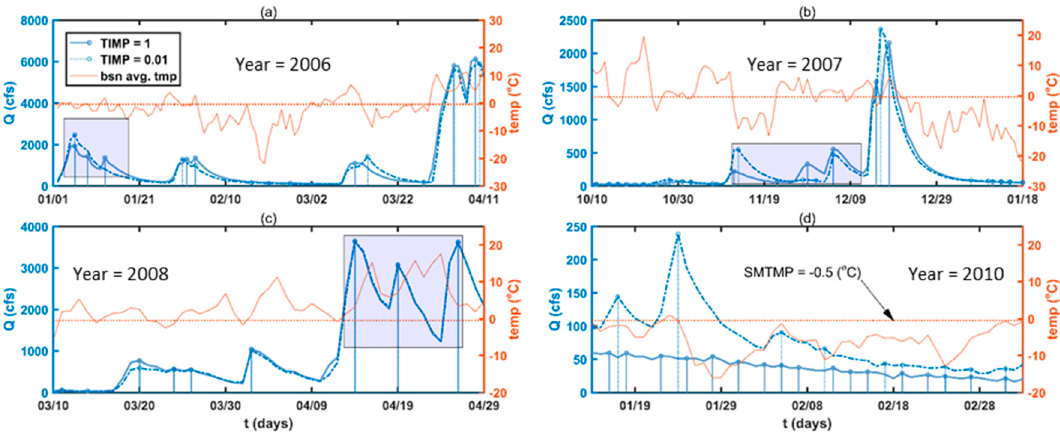
Figure 3. Daily average streamflow change from pre (TIMP = 1) to post (TIMP = 0.01) adjustment contrasted with basin average daily air temperature (derived from averaging daily air temperature from 175 subbasins). The x axis shows the date in MM/DD format. Dots indicate local peak flow values identified by the peak flow selection tool available in HydroME Toolbox. Dotted line represents the threshold temperature for snowmelt. ( a ) shows months January to April for year 2006; ( b ) shows months October to January for year 2007; ( c ) shows months March and April for year 2008; ( d ) shows months January and February for year 2010.